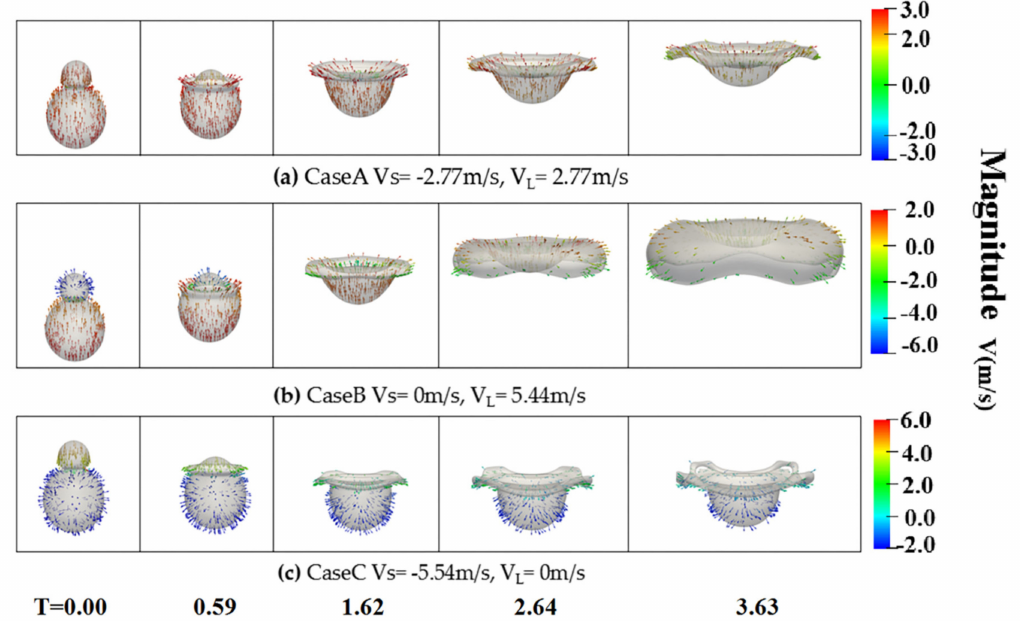
Figure 8. The vector fields inside and around the colliding droplets for the case of We = 210, ∆ = 0.5 at T = 0.00, 0.59, 1.62, 2.64, and 3.63, respectively. ( a ) CaseA V S = − 2.27 m / s, V L = 2.27 m / s, ( b ) CaseB V S = 0 m / s, V L = 5.54 m / s, ( c ) CaseC V S = − 5.54 m / s, V L = 0 m /